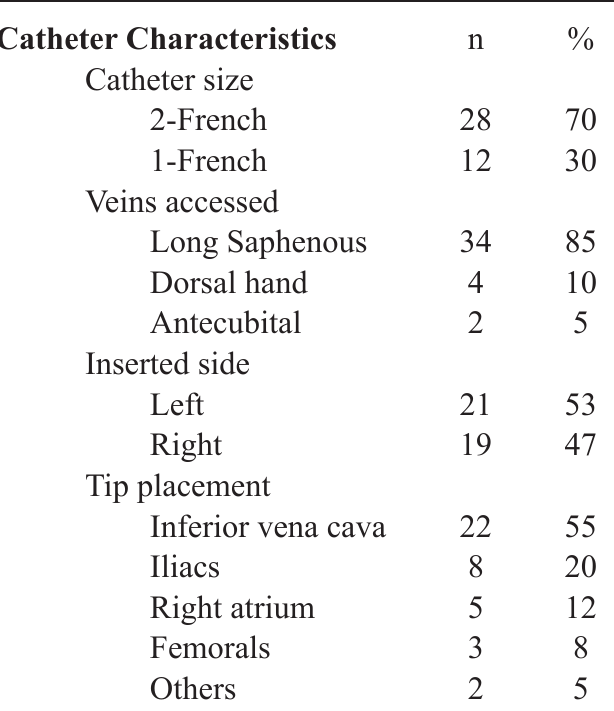
TABLE 1 - Catheter